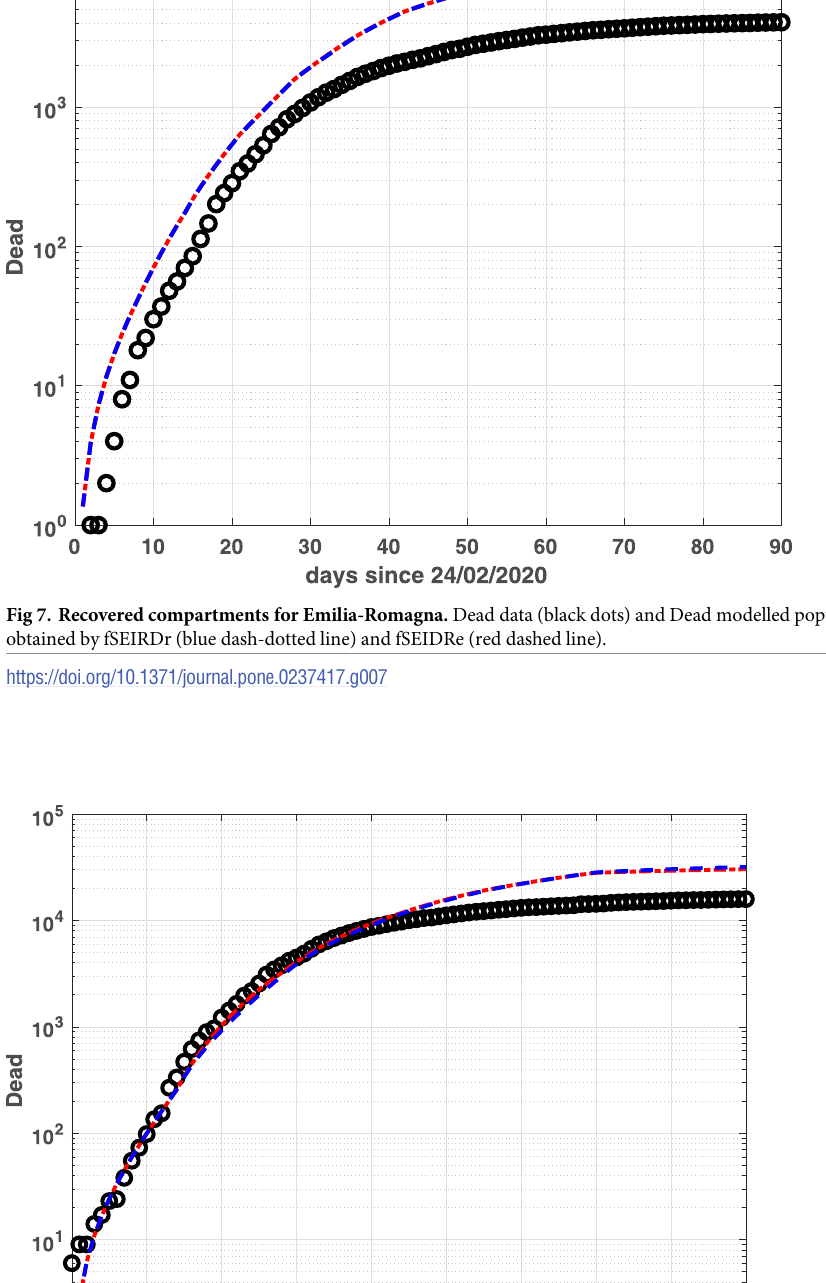
PLOS ONE | https://doi.org/10.1371/journal.pone.0237417 August 6,